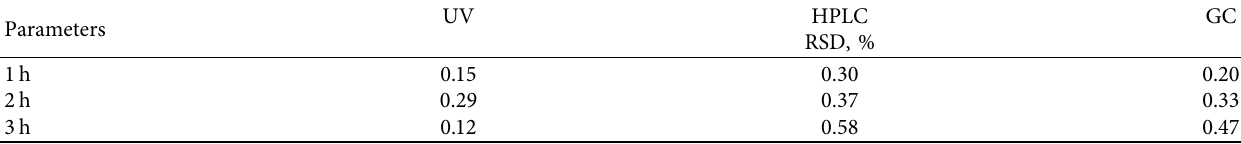
Table 2: Investigation of the stability of BAC solutions over time.